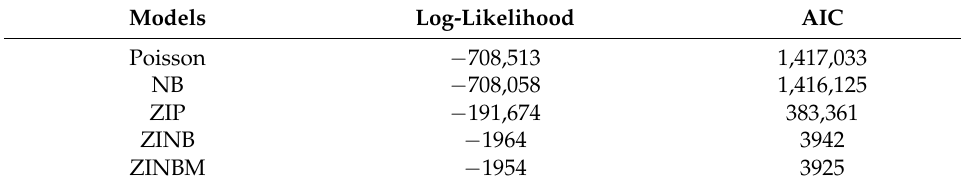
Table 6. Comparison of fit measures of models. Models